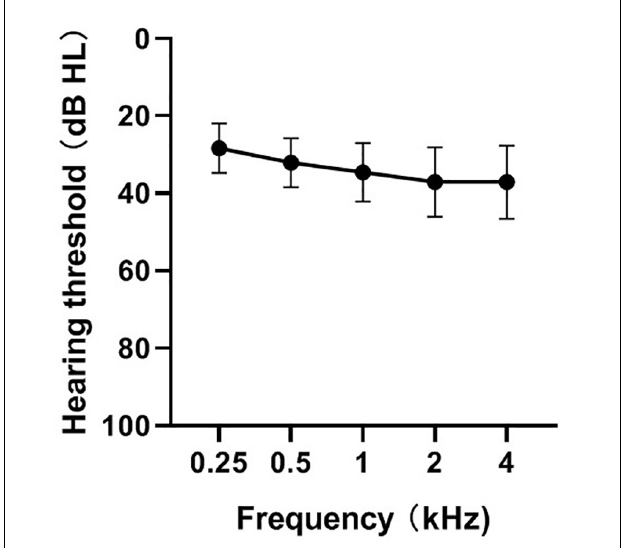
FIGURE 1 | Mean hearing thresholds at frequencies of 0.25, 0.5, 1, 2, 4 kHz in CI ears ( n = 31). The mean (circle) and the standard deviations (error bars) of the mean are